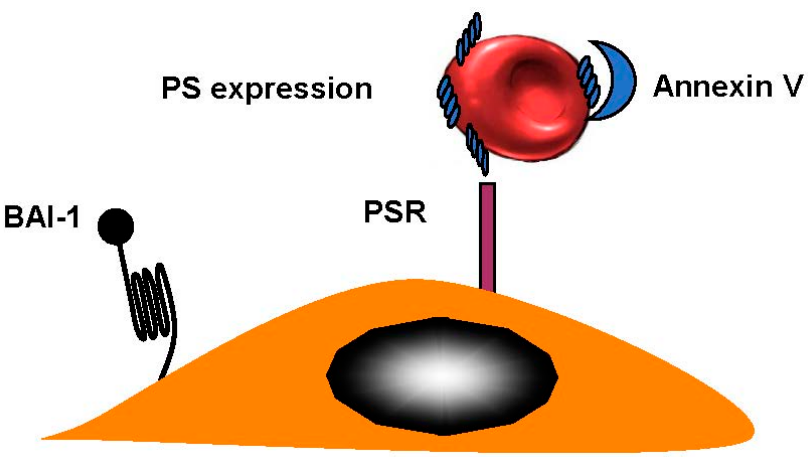
Figure 4. Retinal-vein occlusion. RBCs from patients with retinal-vein occlusion have an enhanced phosphatidylserine (PS) expression and adhere to the endothelium. Brain-specific angiogenesis inhibitor (BAI-1) and phosphatidylserine receptor (PSR), are potential receptors. Blockade of PS RBCs by annexin V or PS receptors on endothelial cells by anti PSR, inhibited adhesion indicating that the couple PS–PSR is responsible for increased adhesion of RBCs from patients with CRVO.